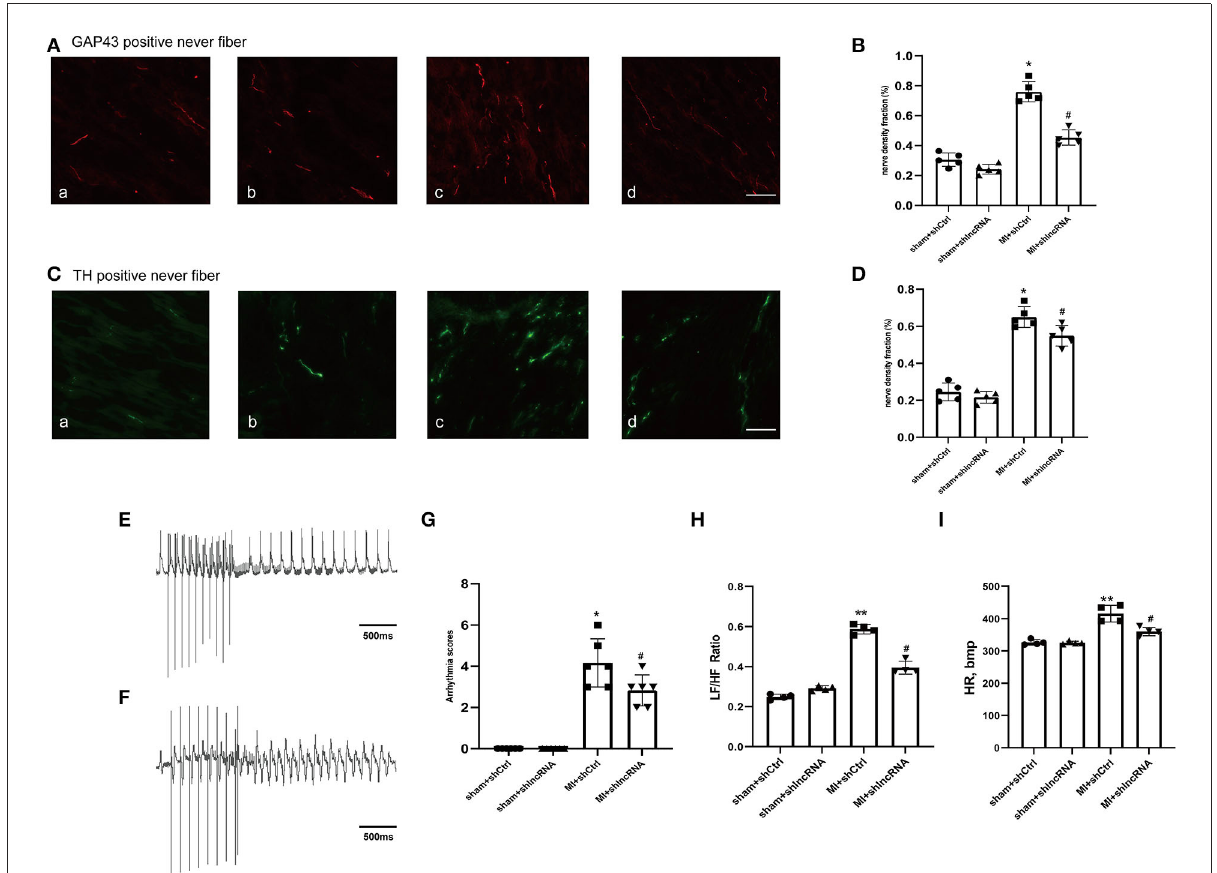
FIGURE6 lncRNA LOC100911717 silencing reduces sympathetic remodeling after MI. (A–C) Immunofluorescence staining of GAP43 and TH in the MI border region (magnification 200 × ). (a) Sham + shCtrl, (b) sham + shlncRNA, (c) MI + shCtrl, and (d) MI + shlncRNA, bar = 50 µ m. (B–D) Fraction (%) of nerve density area, n = 5 per group. (E–F) Normal electrocardiographic recordings and typical inducible VAs. (G) Arrhythmia scores from the four groups, sham + shCtrl, sham + shlncRNA, MI + shCtrl, and MI + shlncRNA; n = 6 per group. (H–I ) Are statistical plots of the HRV analysis for each group of rats. *A P- value of < 0.05 compared with the sham group, **A P- value of < 0.01 compared with the sham group, # A P- value of < 0.05 compared with the MI + shCtrl